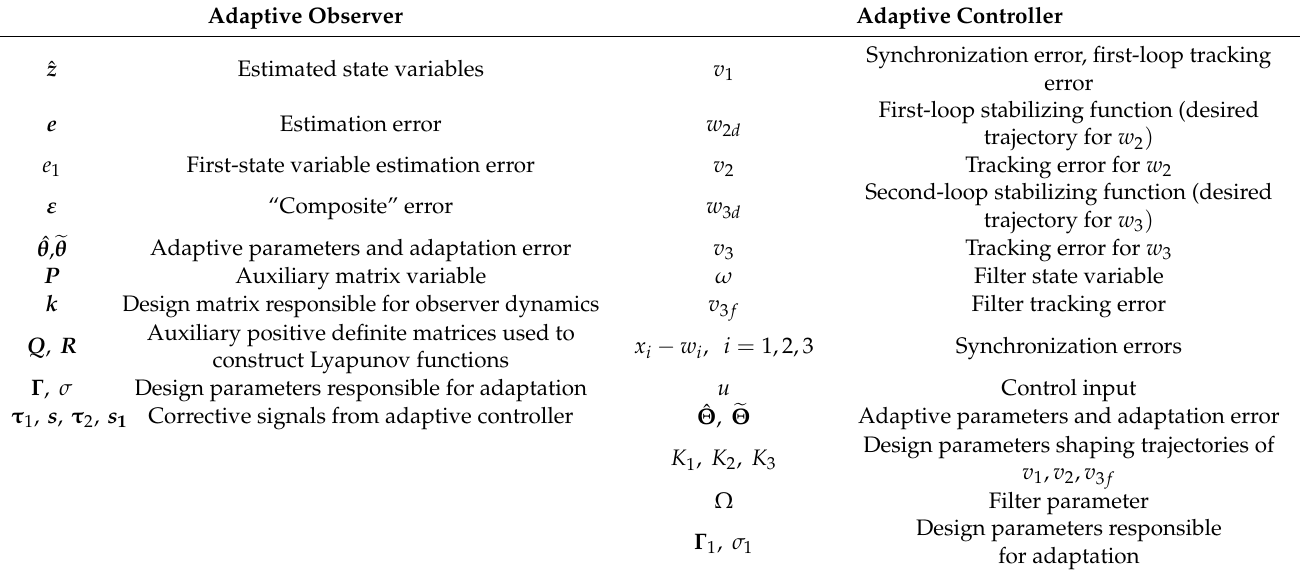
Table 1. Important signals and